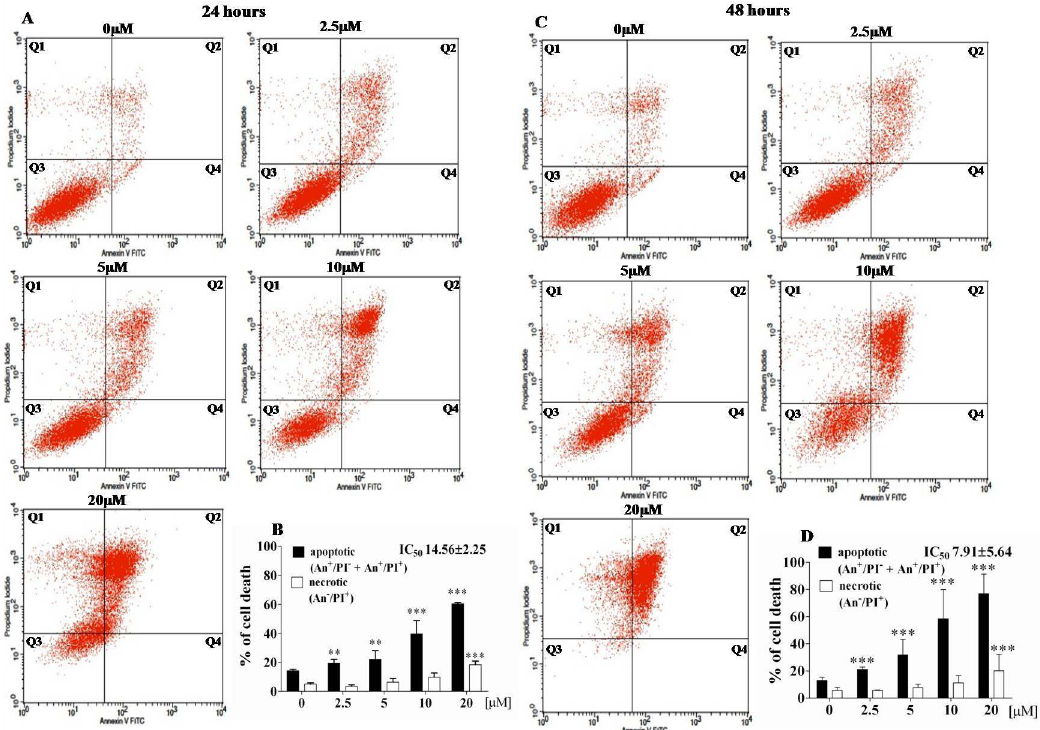
Figure 6. E ff ect of compound 3a on apoptosis / necrosis induction in the RPMI 8226 cells. After the 24-h ( A ) and 48-h ( C ) exposure to the di ff erent concentrations of compound 3a , the cells were stained with Annexin (An) V-FITC / propidium iodide (PI) and examined with flow cytometry. Quadrant Q1 represents An − / PI + necrotic cells, Q2—An + / PI + late apoptotic cells, Q3—An − / PI − viable cells, Q4—An + / PI − early apoptotic cells. Histogram representation of the quantitative percentage of total apoptotic cells (early + late apoptosis) and necrotic cells in the control and compound 3a -treated cell cultures after the 24-h ( B ) and 48-h ( D ) treatment. All experiments were repeated independently at least three times, and data ( n = 6 for each concentration) are expressed as mean ± SD; ** p < 0.01 and *** p < 0.001 in comparison to the control; one-way ANOVA